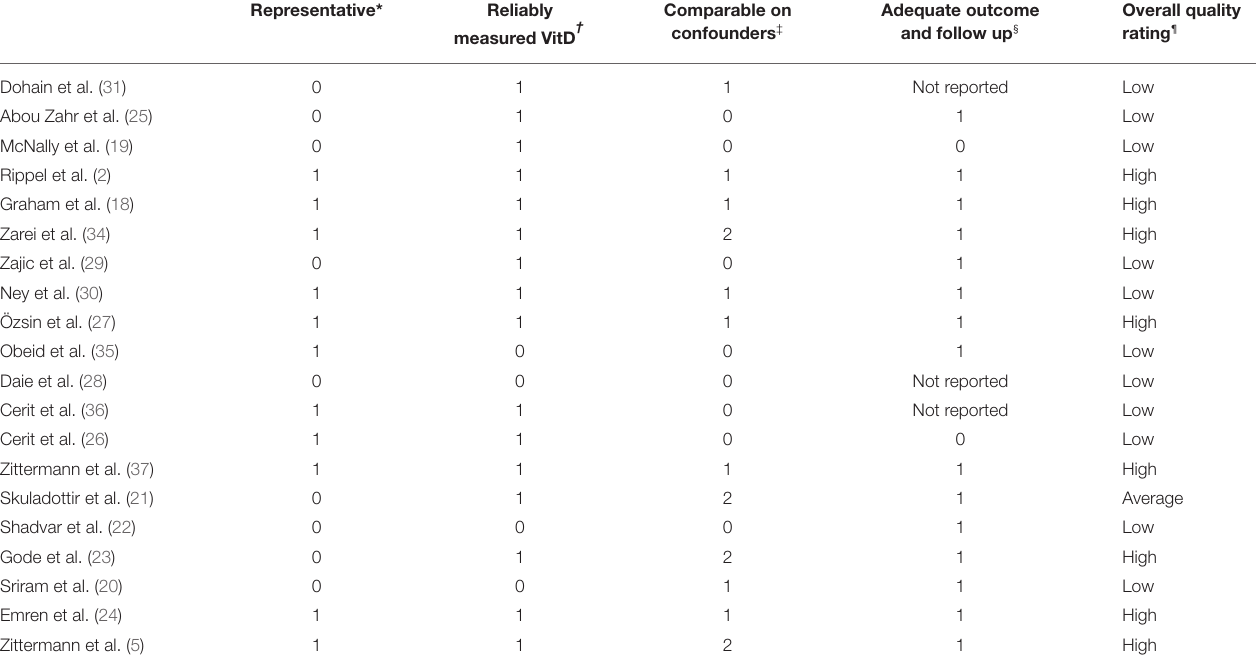
TABLE 2 | Quality assessment of studies using criteria adapted from Newcastle-Ottawa quality assessment scale (32,